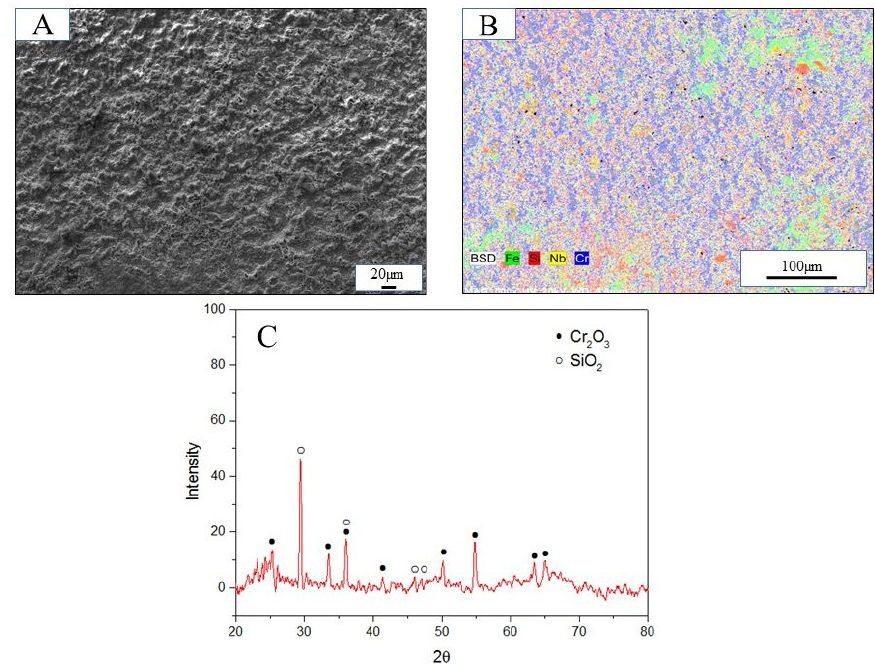
Figure 6. Images on the surface oxide layer after the oxidation test for the coated alloy being: A SEM/SE image, B EDXA mapping and C X-Ray